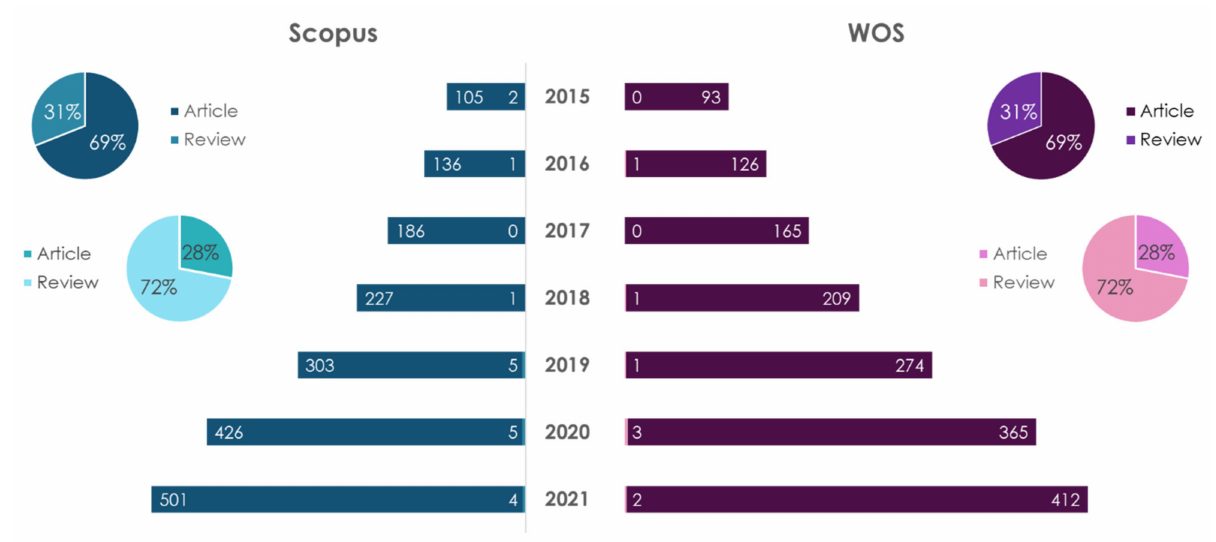
Figure 10. Statistical results of the search in Scopus/WOS databases by the keywords “ketogenic diet” (dark color) and “ketogenic diet and atherosclerosis” (light